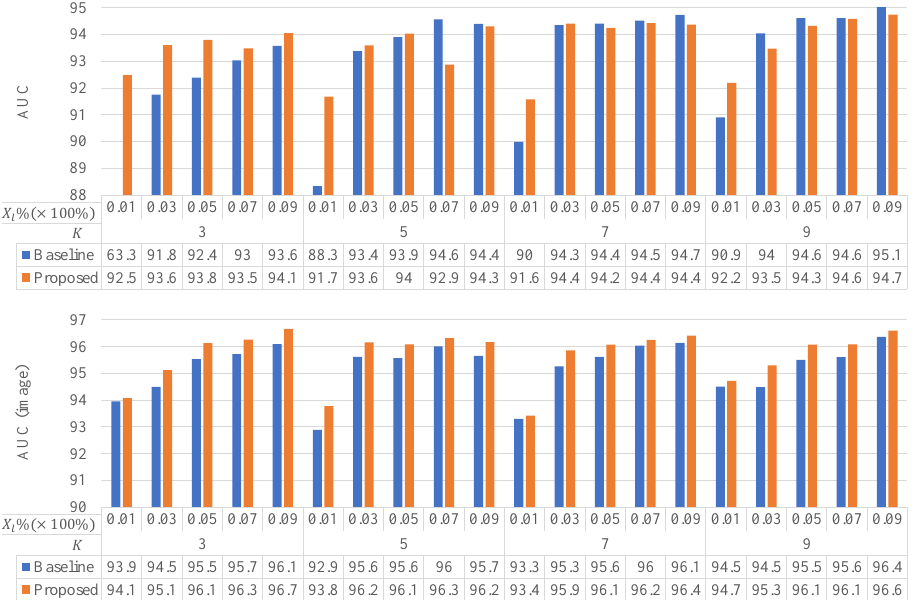
Figure 9. The effect of the amount of